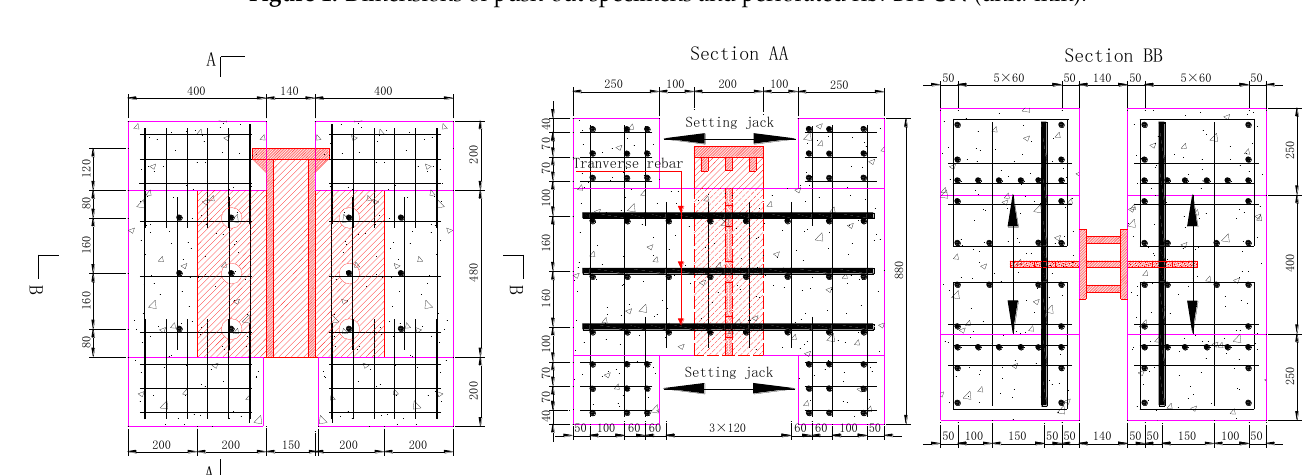
Figure 2. Dimensions of push-out specimens and perforated rib: BH-PT (unit: mm).